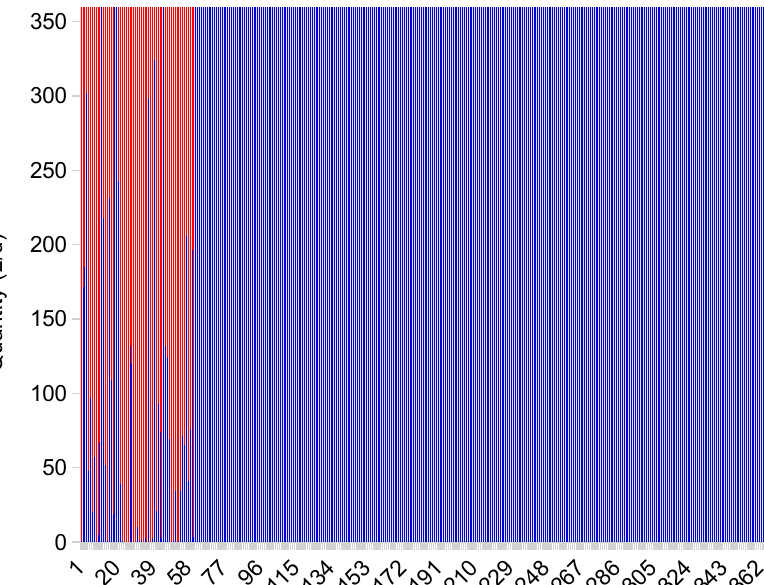
Figure 5. Daily requirements supplied through RWH (blue bars) and the corresponding required supplementary supply (red bars) to meet a demand of 720 L d − 1 for a given family for a catchment area of 200 m 2 . Note that for any given day, the demand that is not met through RWH, is met through supplementary sources to meet the total demand (i.e., 720 L d − 1 ).